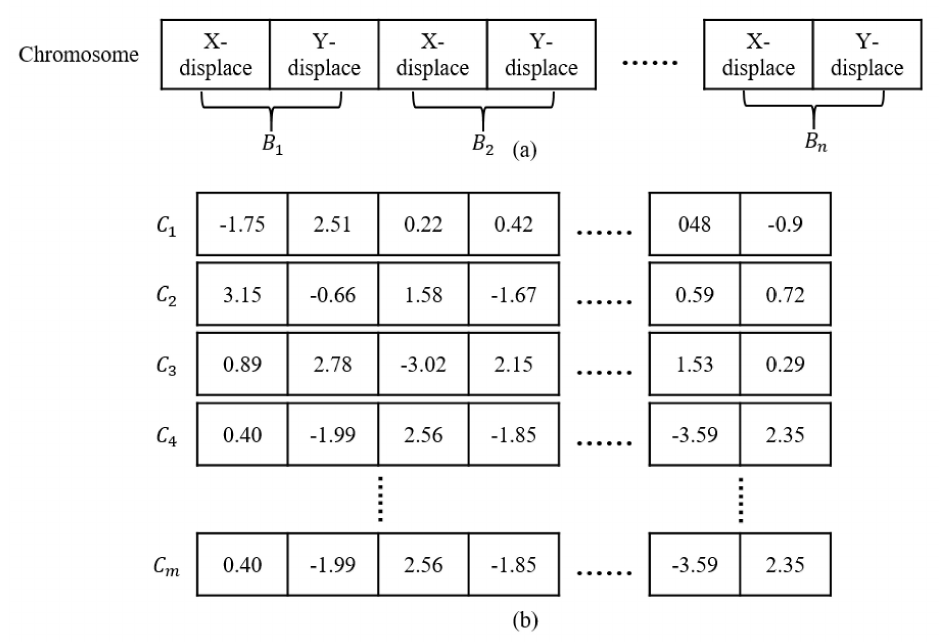
Figure 2. Representation of a chromosome and a population. ( a ) One chromosome, B i ( i = 1,2, ... , n ) represents the displacement distance of the i th building in the X and Y directions; ( b ) One population, C j ( i = 1,2, ... , m ) represents the j th chromosome or individual in a population, which is composed of N buildings assembled together by displacement distances in the X and Y